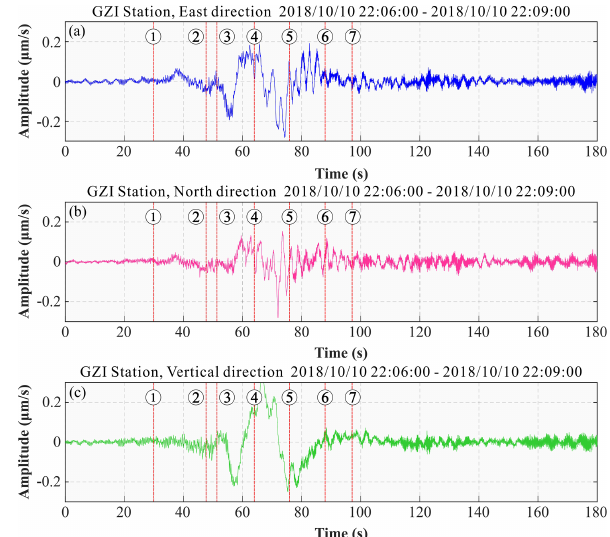
Figure 6. Time domain velocity signal (E \ N \ V direction) of the seismic generated by the Baige landslide at GZI seismic station, visually showing a relatively high signal-to-noise ratio. The points labeled (1)–(7) refer to the characteristic stages of the Baige land-